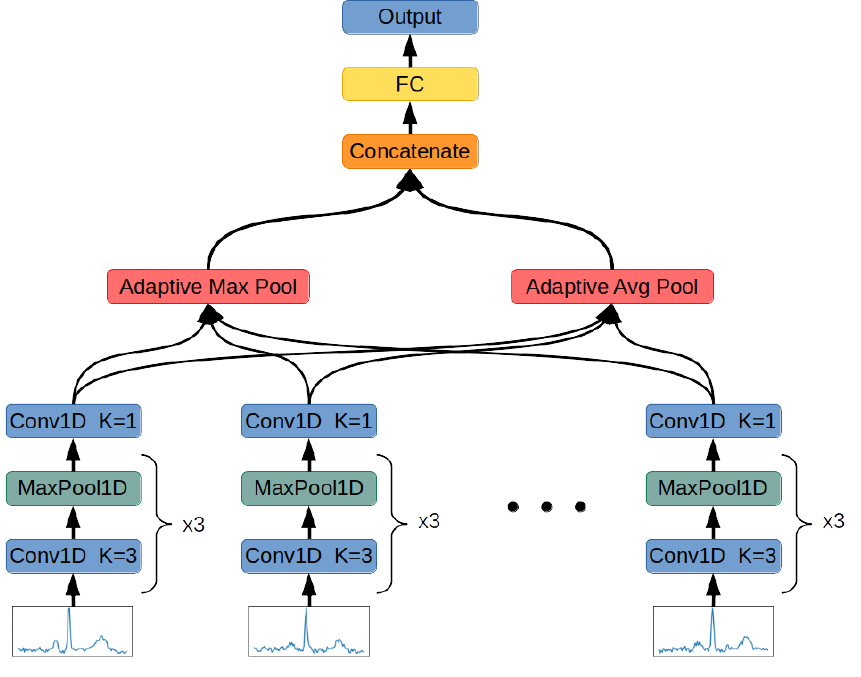
Figure 5. Designed Neural Network